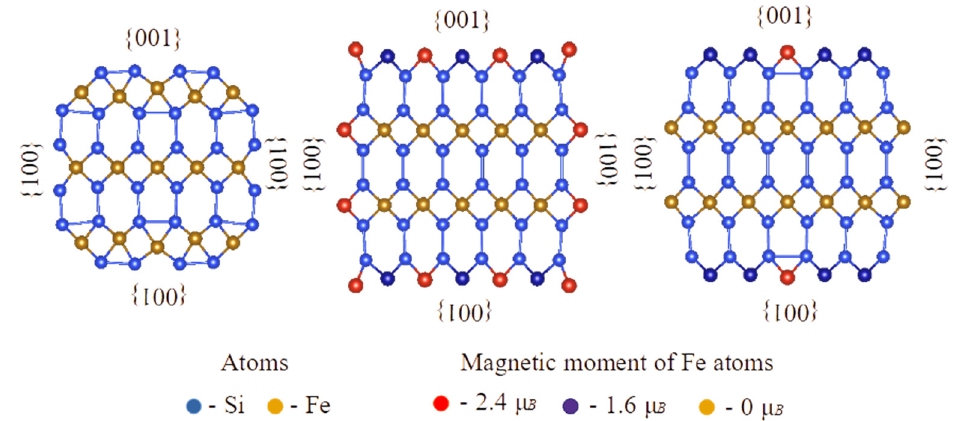
Figure 8. Cross sections of <100>-oriented α -FeSi 2 NWs with different morphologies indicating